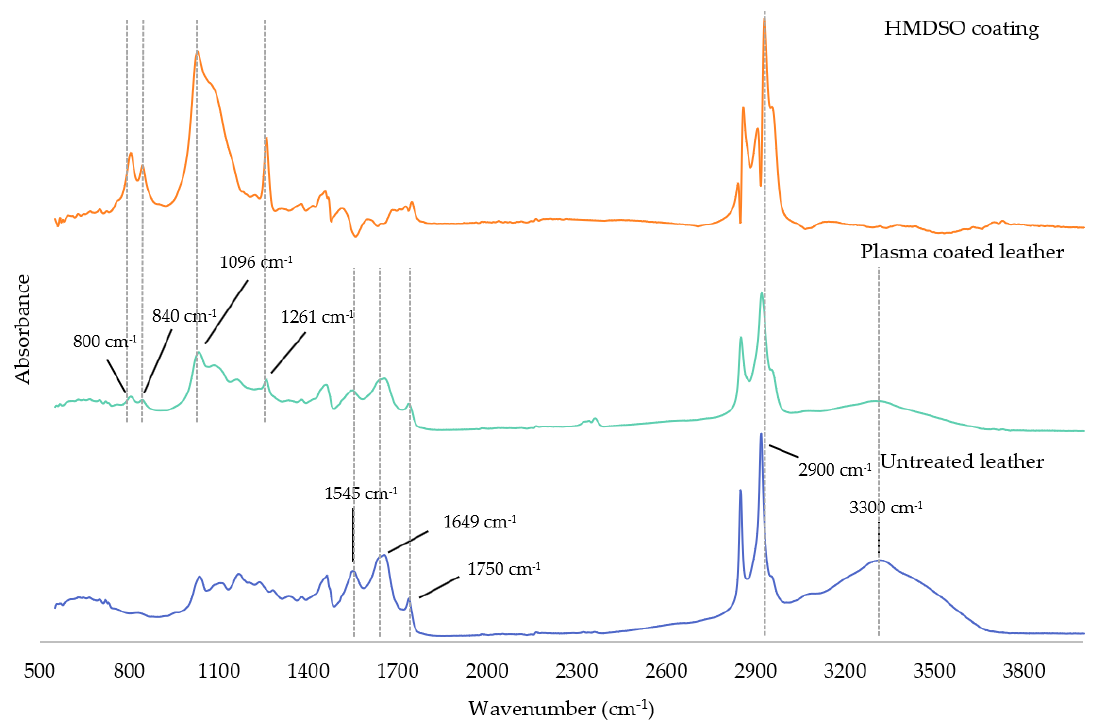
Figure 2. FTIR spectra of untreated leather sample, plasma coated leather and HMDSO plasma polymerised onto the leather surface. Table 3. Assignments of the main FTIR absorption bands observed for the spectra in Figure 2. Wavenumber Assignment